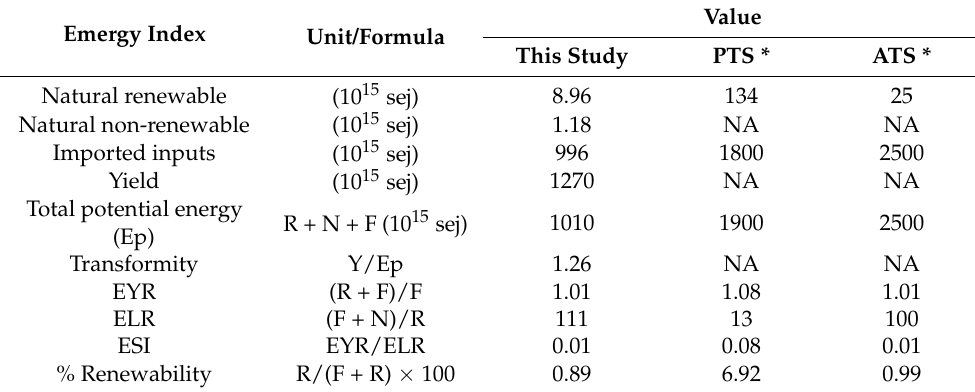
Table 2. Emergy indices for the microalgae-based AMD treatment. Emergy Index